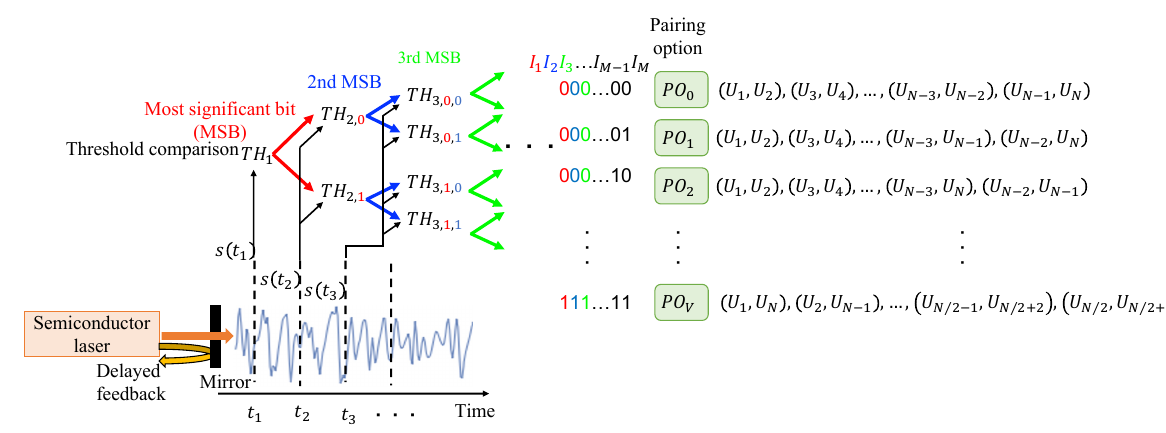
Figure 5. User pairing using the laser chaos decision-maker.